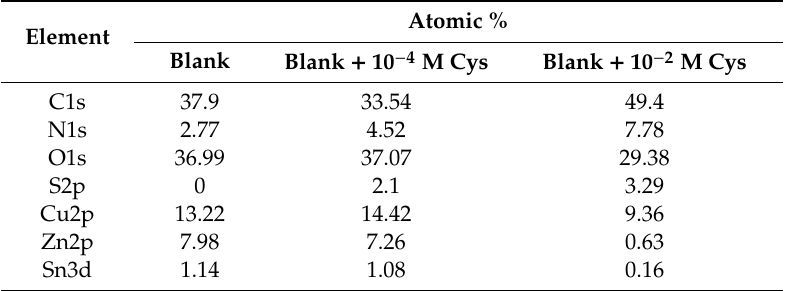
Table 3. Composition (atomic %) of the surface of Cu5Zn5Al1Sn alloy samples before and after the addition of inhibitors in a 3.5 wt.% NaCl solution.